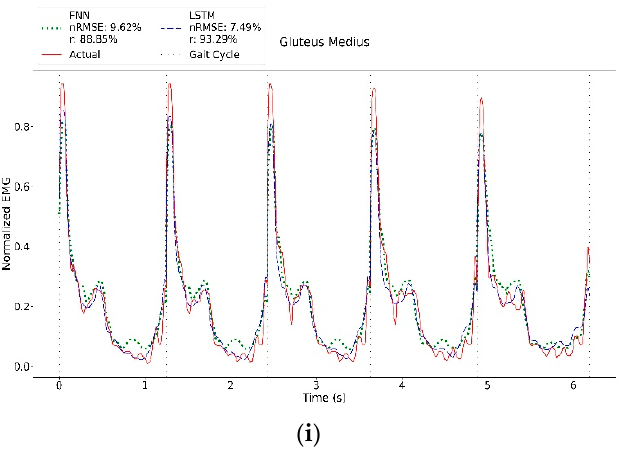
Figure 4. A sample of the actual and predicted muscle activities of the test data of ( a ) gastrocnemius, ( b ) tibialis anterior, ( c ) soleus, ( d ) vastus medialis, ( e ) vastus lateralis, ( f ) rectus femoris, ( g ) biceps femoris, ( h ) semitendinosus, ( i ) gluteus medius.